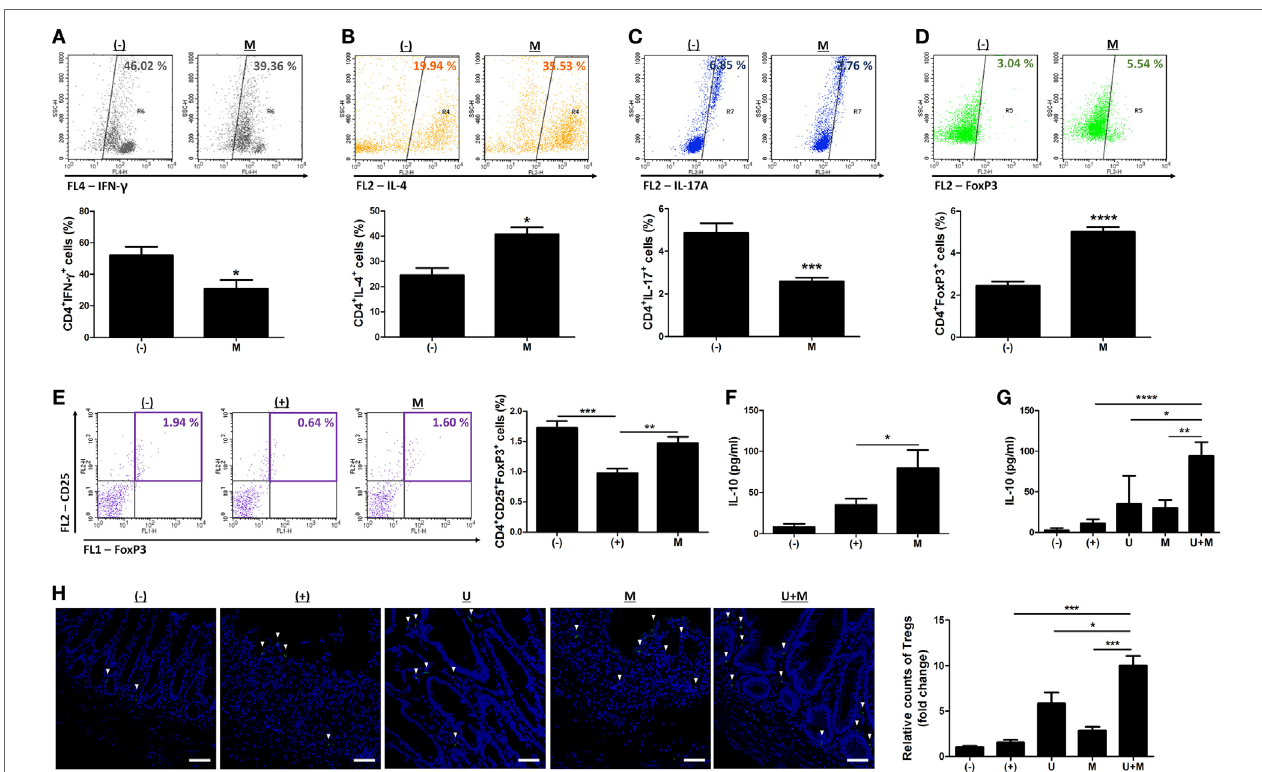
FigUre 5 | MIS416 and human adult stem cells, including umbilical cord blood-derived mesenchymal stem cells (hUCB-MSCs) cooperate in intestinal homeostasis by regulating polarization of T helper (Th) cells. (a–D) hUCB-MNCs were cultured with MIS416 for 3 days and analyzed for each population of Th lineages by flow cytometric analysis. Populations of (a) CD4 + IFN (interferon)- γ + cells for Th1, (B) CD4 + IL-4 + cells for Th2, (c) CD4 + IL-17A + cells for Th17, and (D) CD4 + FoxP3 + cells for regulatory T cells were determined. (e,F) Each group of mice were sacrificed a day after MIS416 administration (day 2). (e) Populations of CD4 + CD25 + FoxP3 + cells in spleen were analyzed by flow cytometric analysis. (F) The levels of IL-10 in serum were detected by CBA analysis. (g,h) Each group of mice was sacrificed on day 11. (F) The levels of IL-10 in serum were measured by CBA. (g) Representative images of FoxP3-immunostained colons, bar = 100 µm, and the quantification. ▾ ; FoxP3 + cells. n = 7–8 mice per group, two independent animal experiments were performed. In vitro experiments were performed in triplicate. ( − ): negative control group, ( + ): DSS administered group, U: hUCB-MSCs-treated group, M: MIS416-treated group, U + M: hUCB-MSCs and MIS416 co-treated group. * P < 0.05, ** P < 0.01, *** P < 0.001, **** P < 0.0001. Results are shown as the mean ±